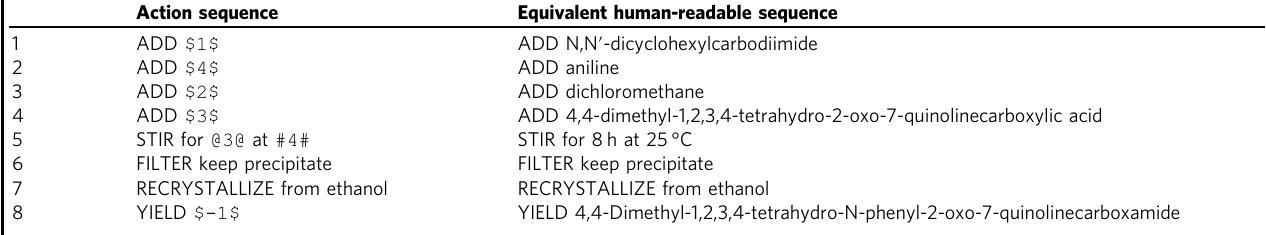
Table 1 Possible action sequence for the chemical equation of Fig. 2.